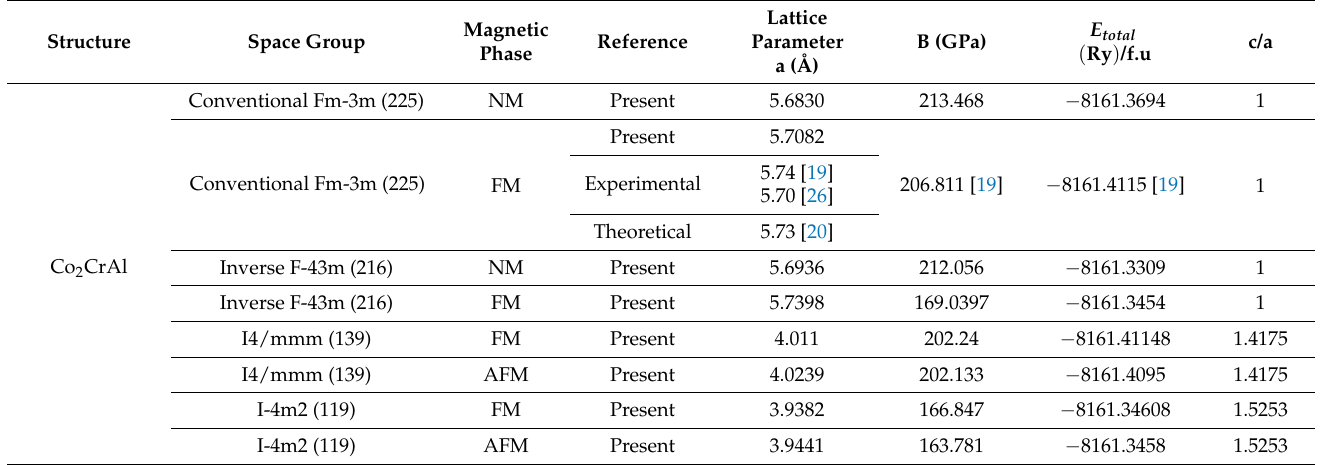
Table 1. Calculated lattice parameter (a), bulk modulus (B), and total energy (E tot ) for Heusler Co 2 CrAl compound.